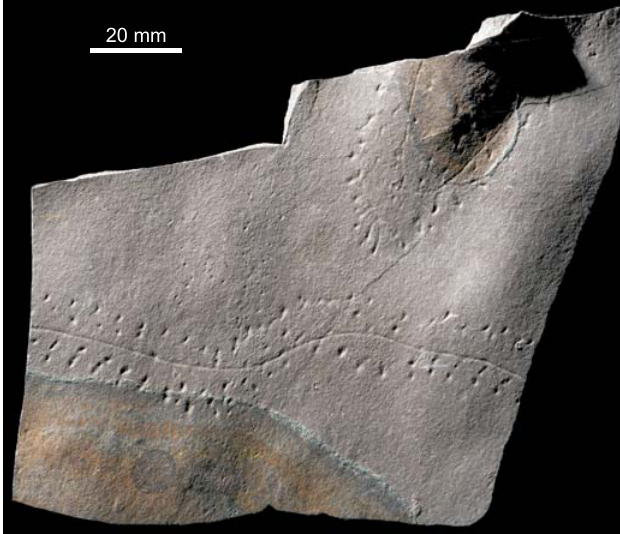
Fig. 9. The lectotype of Stiaria intermedia Smith, 1909 (see also Fig. 8H), Epichnion, Old Red Sandstone, Lower Devonian, Dunure (GSE 14075), Scotland, UK. Published with permission of the British Geological Survey in